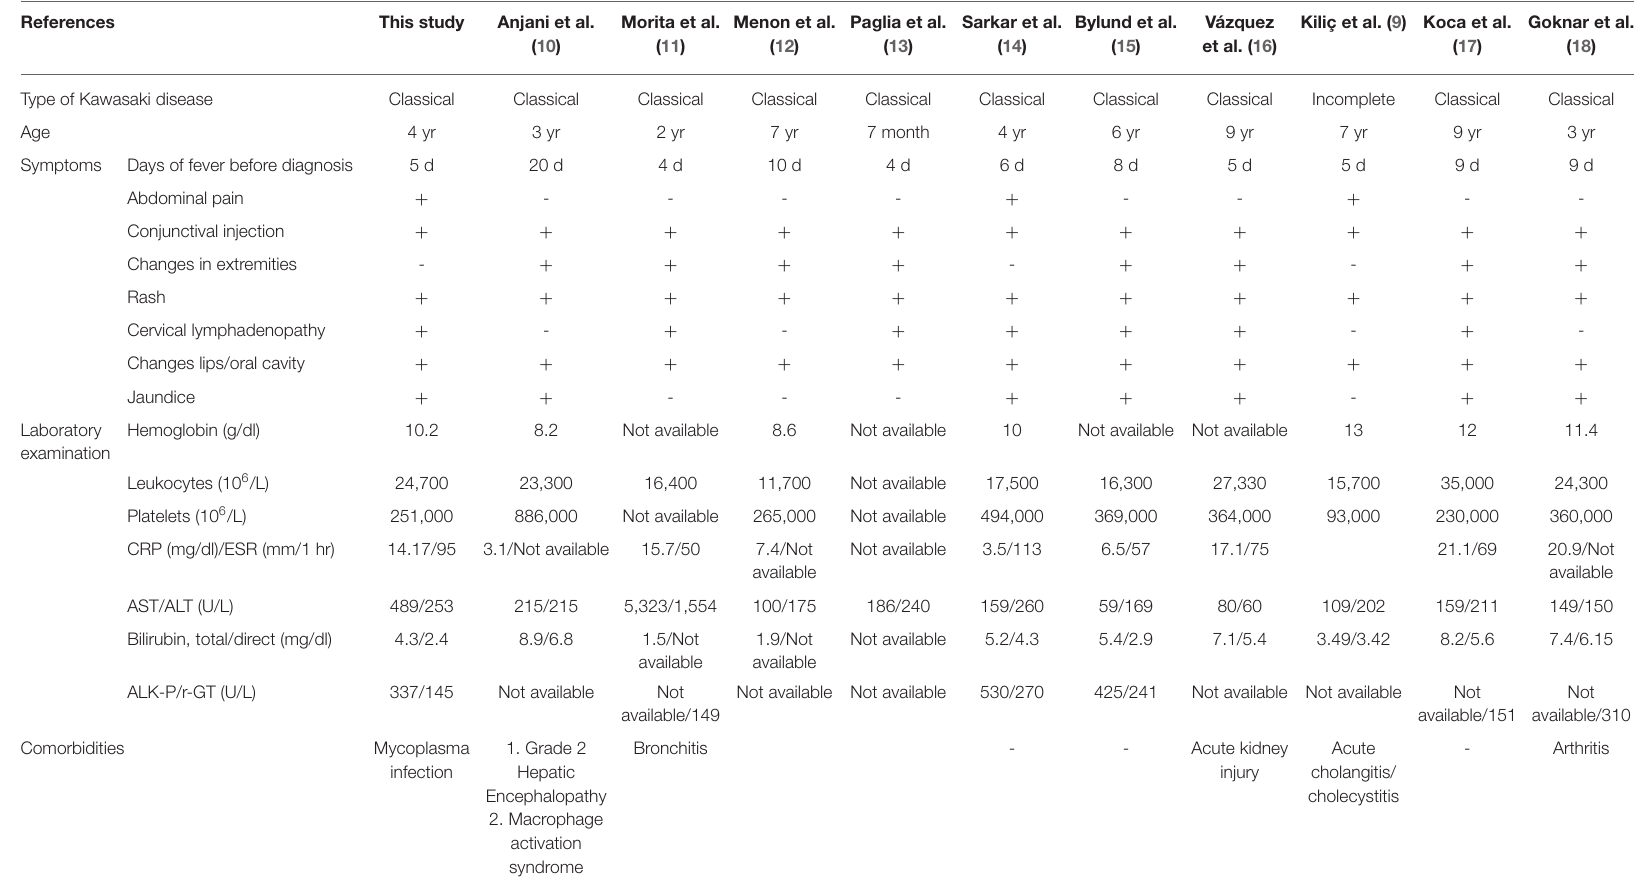
TABLE 3 | Clinical characteristics of 33 patients with KD and hepatobiliary